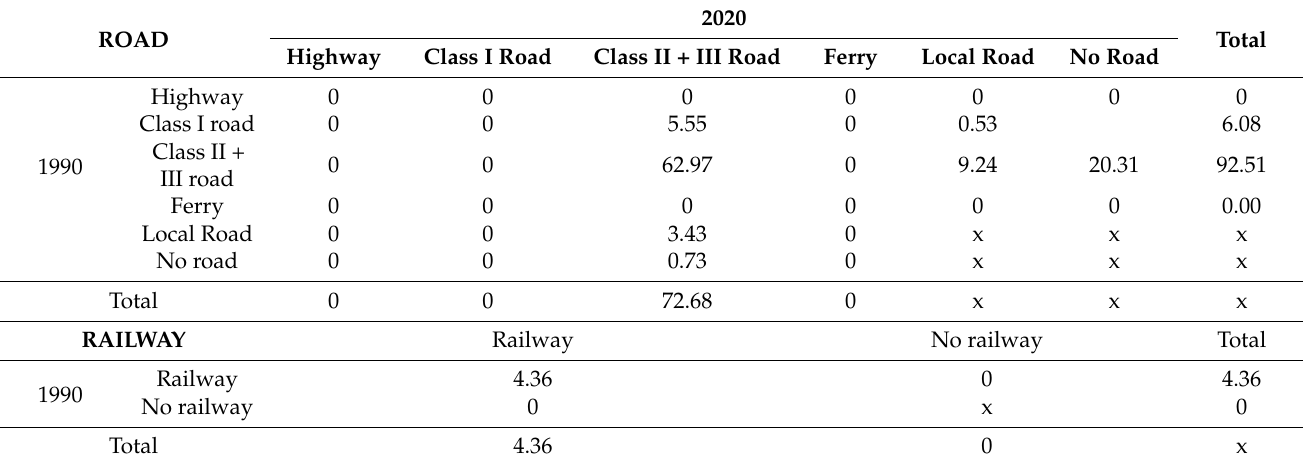
Table 8. The transport network changes: the lakes constructed ( n = 3) in 1990/2020 [km].